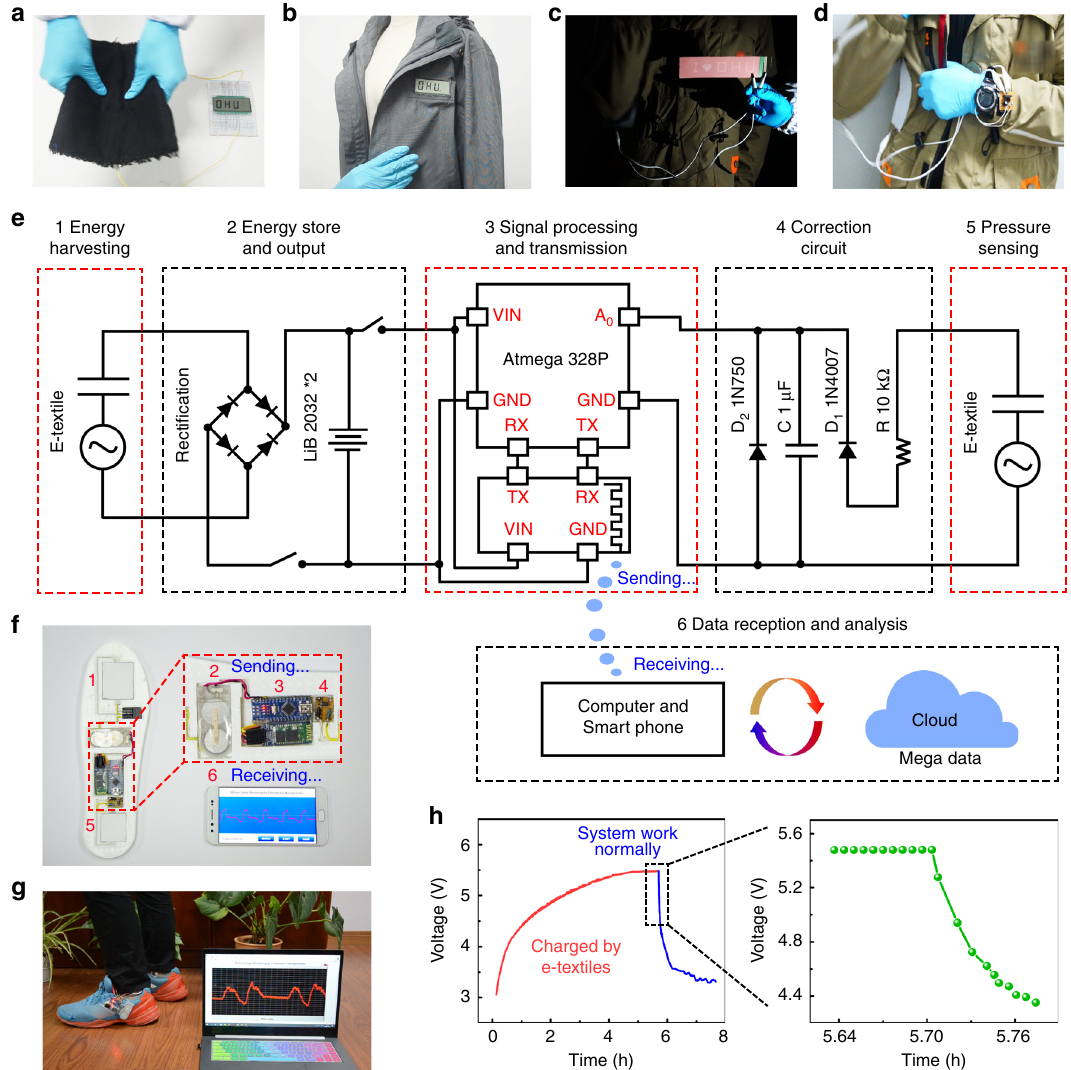
Fig. 5 Various applications of the e-textile. The e-textile is a sewn together with common fabrics and b sewn into clothes to power the LCD by shaking the clothes. E-textile is sewn on the surface of clothes to drive c digital electroluminescent lattices and d electronic watch by collecting the energy of shoulder movement. e E-textiles are used for self-charging, self-sensing gesture monitoring system. The circuit diagram of the self-charging and self-sensing wireless gesture monitoring system. It mainly consists of 6 parts, which are: 1, Energy harvesting; 2, Energy storage and output; 3, Signal processing and transmission; 4, Correction circuit; 5, Pressure sensing; 6, Data reception and analysis. The short distance wireless communication technology was used to send and receive data in real time. f Hardware connection of self-powered gesture monitoring system placed on a 3D-printed insole. g Self-powered gesture monitoring system captures gait during human movement and transmits it to smartphone or computer in real time. h The charge curve of two commercial lithium batteries (LIR 2032) charged by e-textile at a fi xed frequency of 2 Hz and the discharge curve of gesture monitoring system during normal